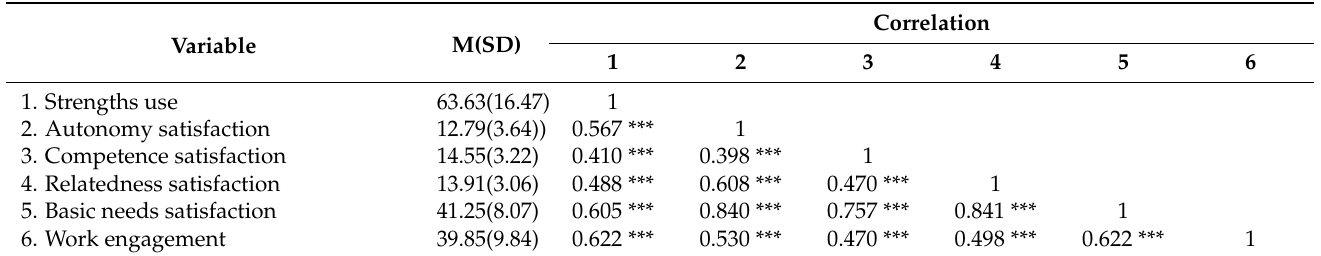
Table 1. Correlations among the variables.